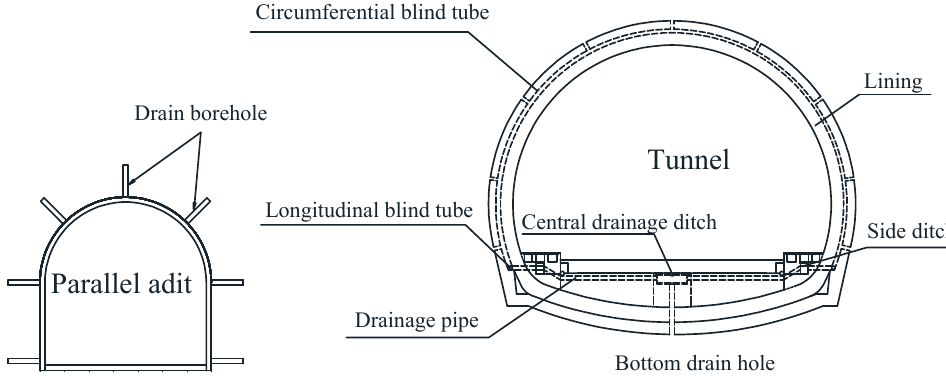
Figure 1. Drainage system for the tunnel with its parallel adit.